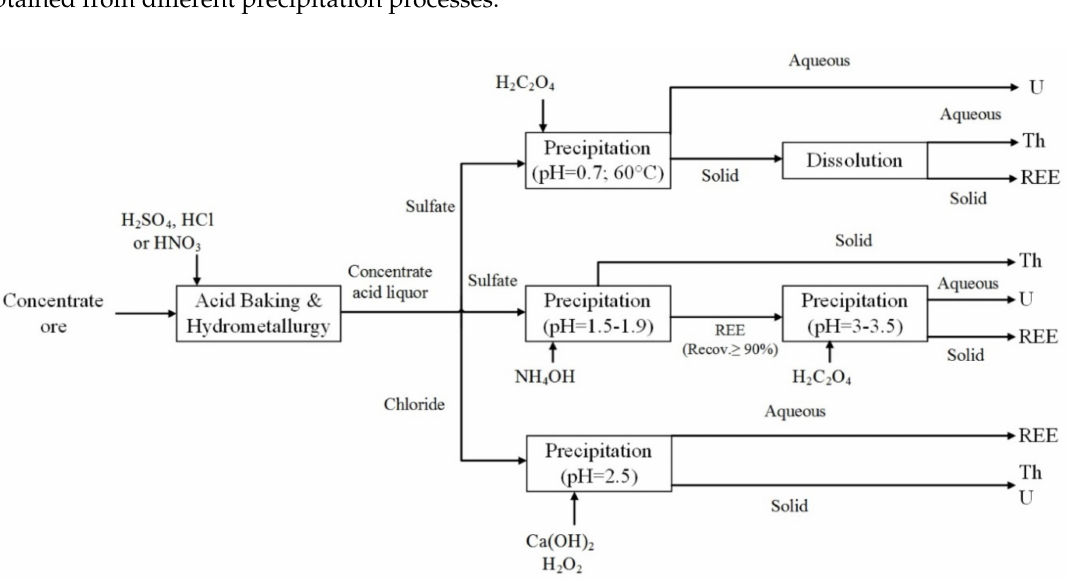
Figure 4. Process flowsheet for separation of Th and U from REE by precipitation. Table 4. Uranium and thorium separation from REE by precipitation